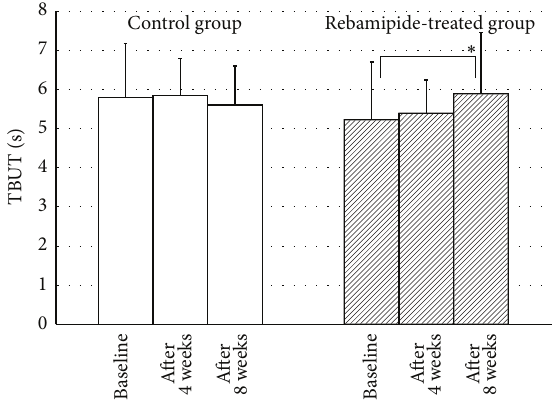
Figure 3: Changes in TBUT in the rebamipide-treated group and control group. Treatment with rebamipide partially but significantly increased TBUT at 8 weeks, although no significant differences were observed at 4 weeks. However, no significant difference was observed in the control group. ∗ 𝑃 < 0.05 .